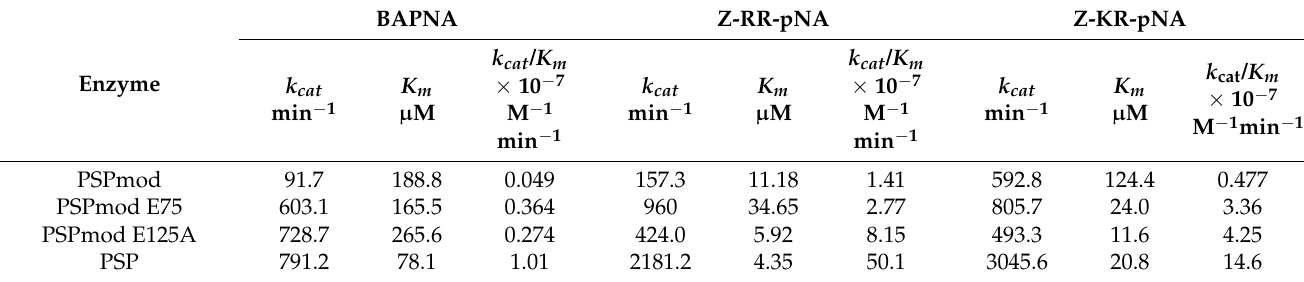
Table 2. Kinetic parameters of hydrolysis of three substrates by PSPmod and its derivatives (0.1 M Tris-HCl, pH 8.0; 2% DMSO, 25 ◦ C). The standard error did not exceed